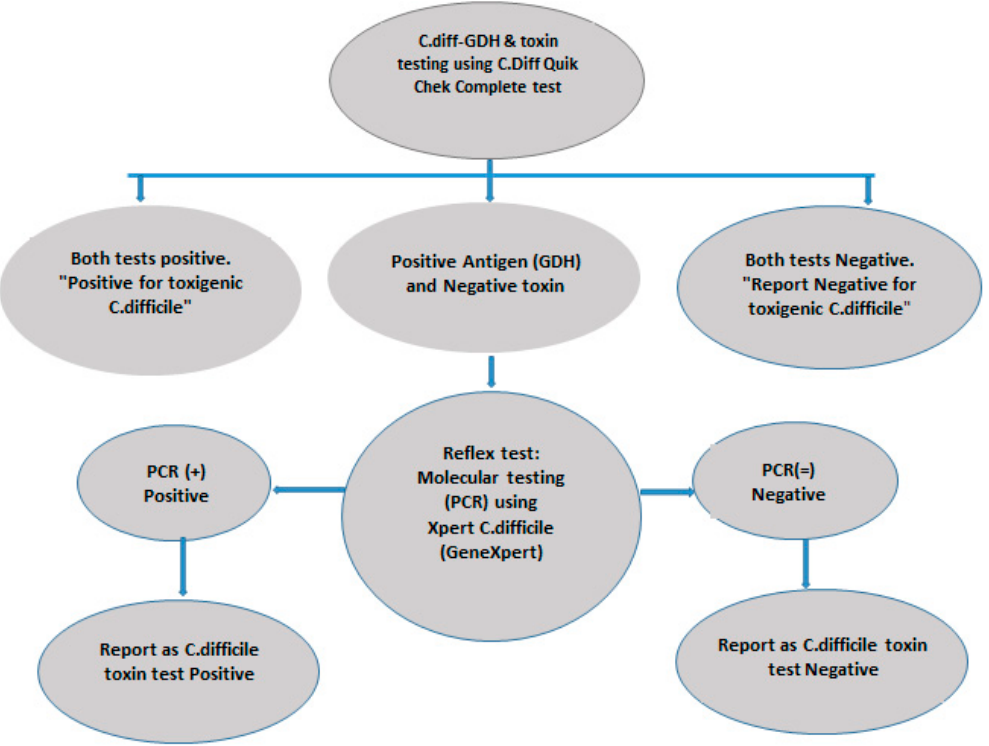
Figure 1. The two-step algorithm for C. difficile testing using Quik Chek Complete dual-antigen enzyme immunoassay (EIA) and Xpert C. difficile PCR. Stool samples were initially screened